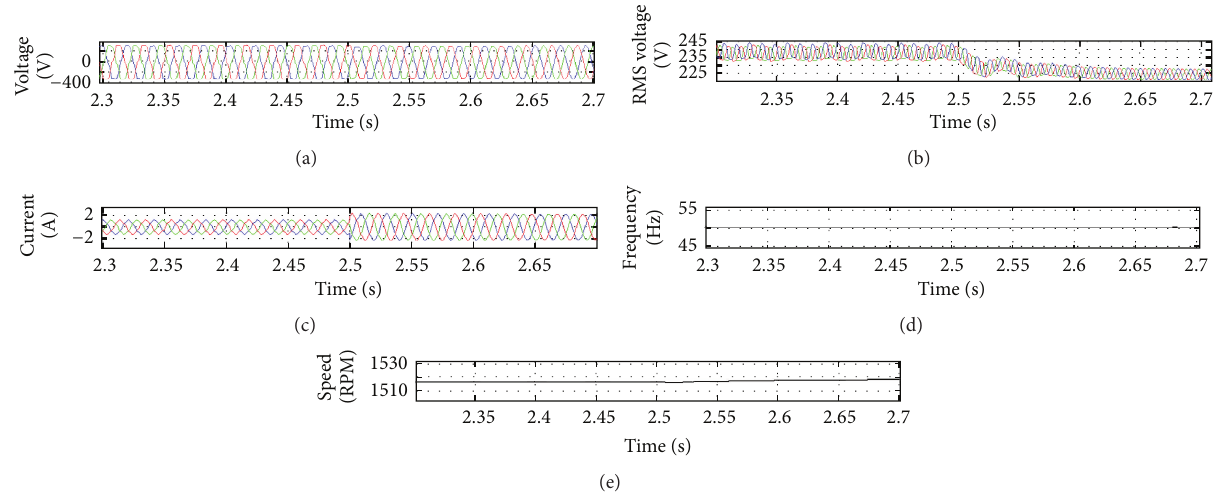
Figure 7: (a) Simulation waveforms of output voltage. (b) Output RMS voltage. (c) Output current. (d) Frequency. (e) Speed.